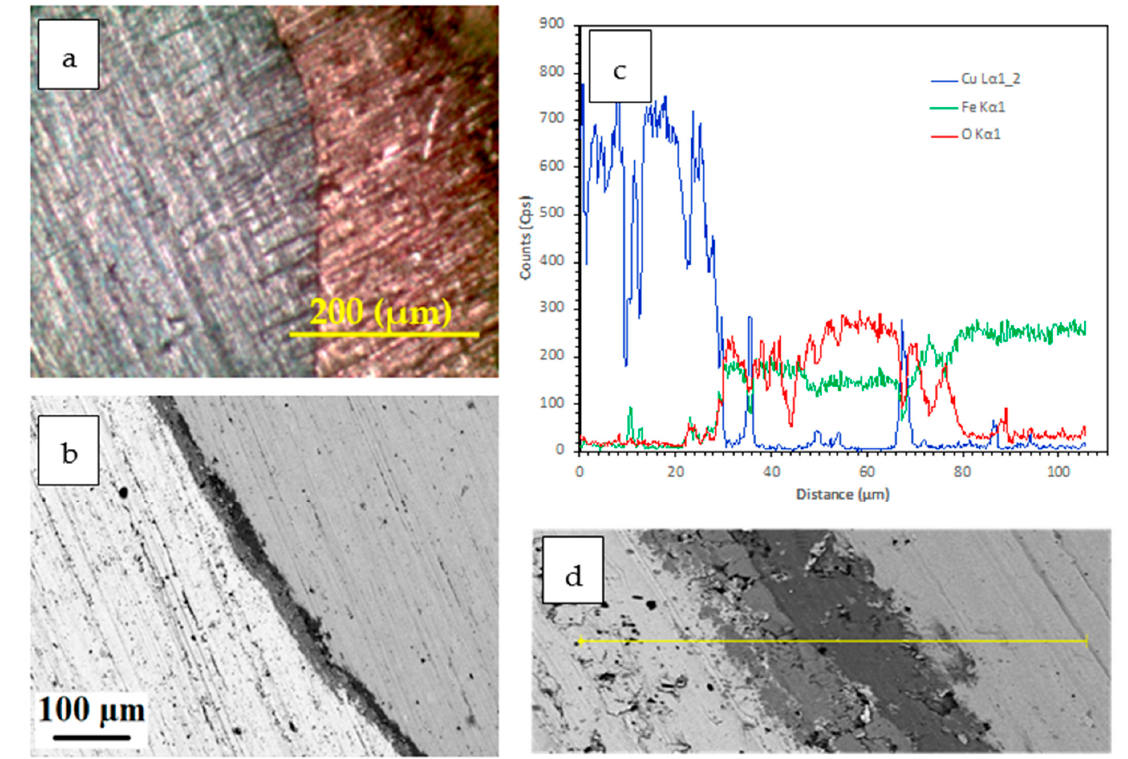
Figure 5. ( a ) Light microscopy image; ( b ) SEM image of a QMMC prepared by pouring molten copper onto the steel rod at 600 °C; ( c ) and ( d ) an EDS spectrum collected from the interface region and corresponding high magnification SEM image.